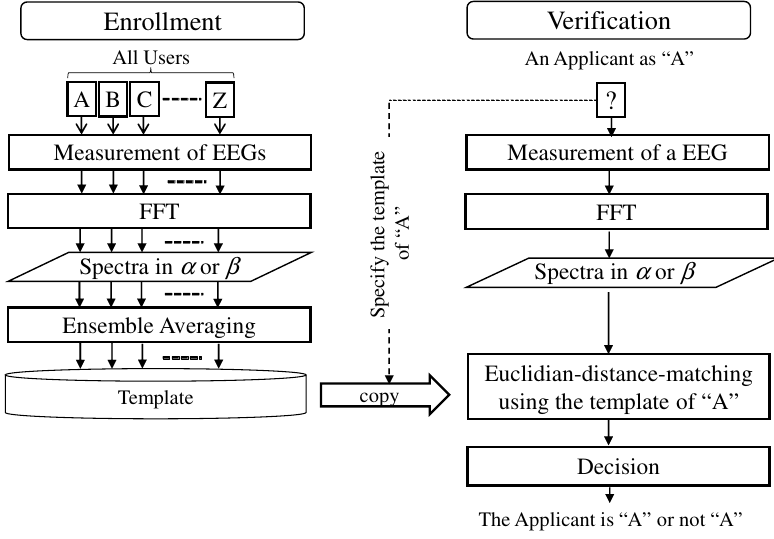
Figure 7. Verification procedure using Euclidean distance